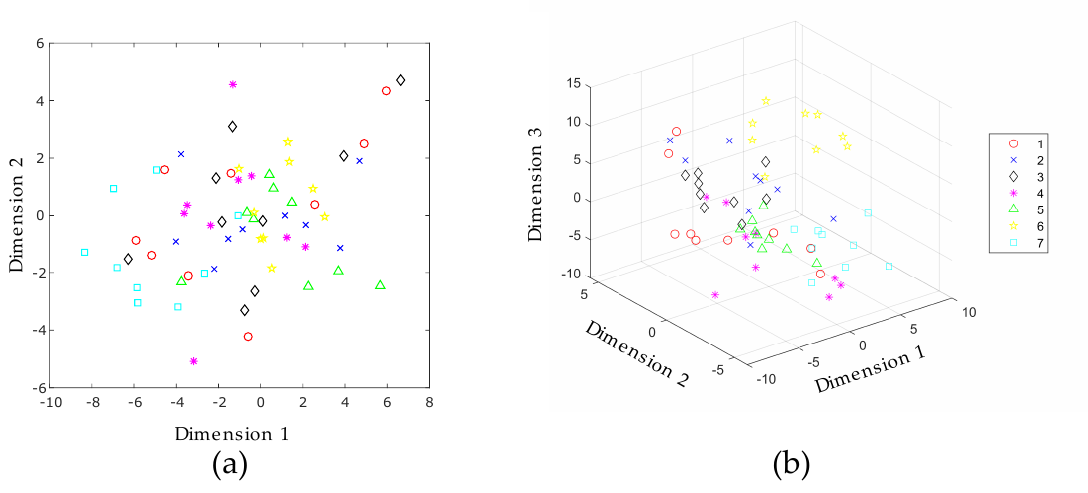
Figure 8. ( a ) Two-dimensional and ( b ) three-dimensional scatter plots after applying t -SNE for a perplexity of 38. The numbers in the legend refers to the seven classes of aqueous matrices as follows: red wine (1) white spirit (2), beer (3), black tea (4), oolong tea (5), maofeng tea (6), and pu (cid:48) er tea